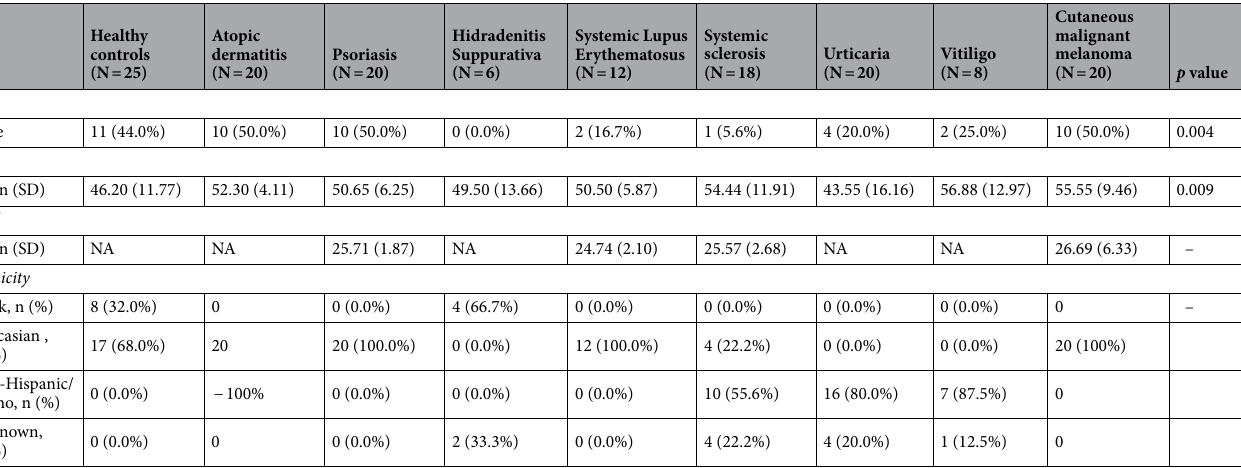
Table 3. Patient Demographics for Cohort 1. Categorical variables are written as number (percentage), while continuous variables are mean (standard deviation). BMI, body mass index.